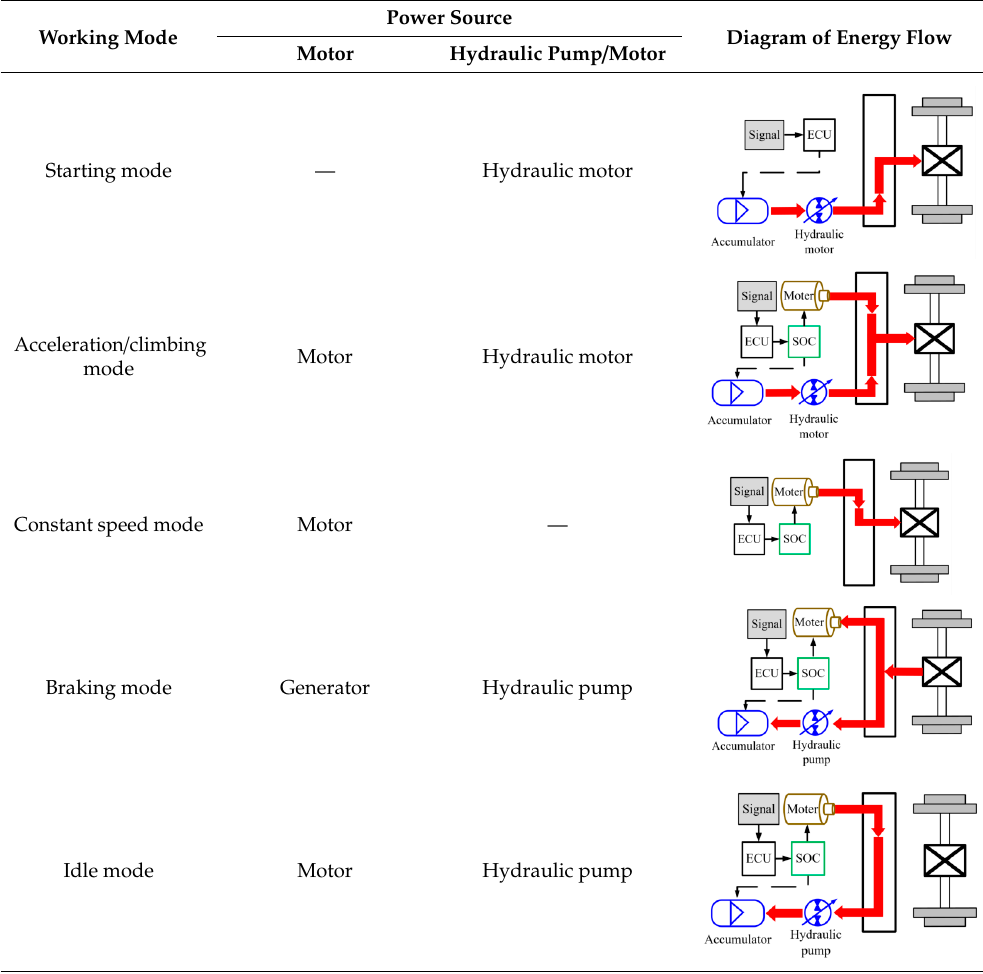
Table 2. Working modes of the MEH-DCDS.